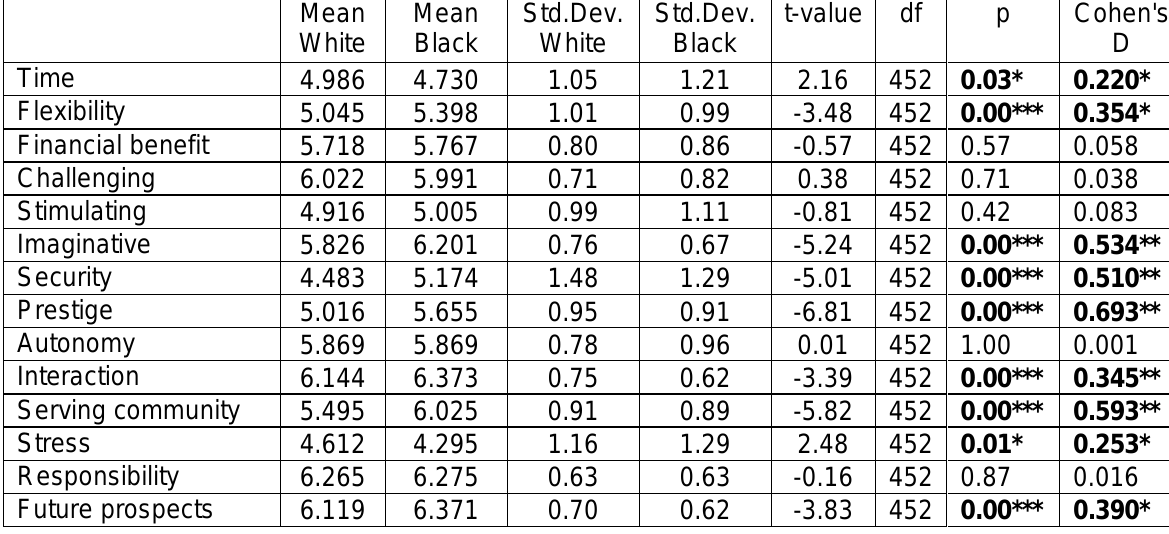
TABLE 6 ETHNICITY OF STUDENTS AND WORK VALUES (WHITE N = 139; BLACK N = 315)